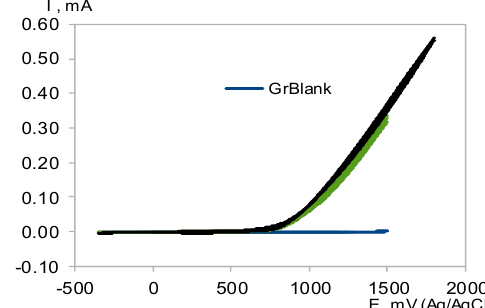
Fig. 3. The cyclic voltammograms measured on electrode Pyr-2 APB in 0.1M, pH 7.4, ν=50 mV/sec three consecutive cycles in the potential range -350 to 1500 mV, and then the two cycles in the potential range 350 - 1800